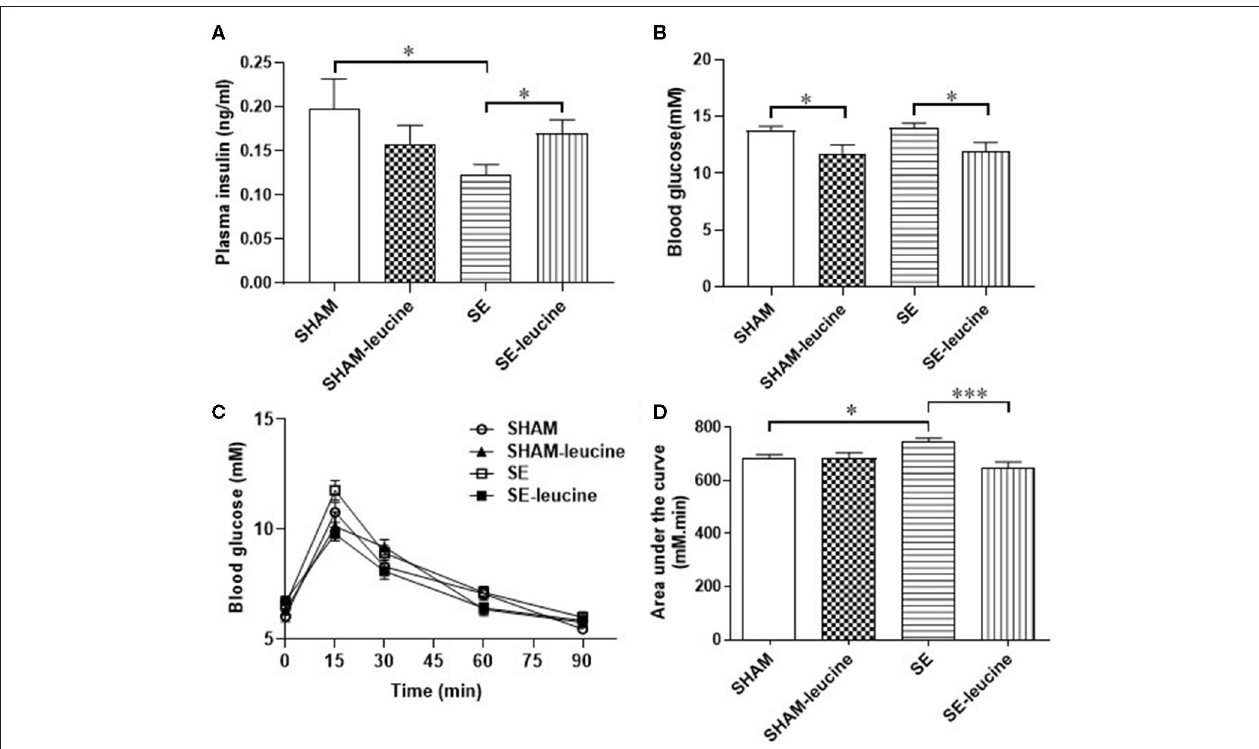
FIGURE 1 | Blood glucose metabolic profile in female offspring. Plasma insulin (A) and blood glucose (B) level in female offspring at 13 weeks. Blood glucose levels during Intraperitoneal glucose tolerance test (IPGTT, C ) and the area under the curve (D) at 12 weeks. Results are expressed as the mean ± SEM ( n = 8), and analyzed by two-way ANOVA, followed by post-hoc LSD tests. * P < 0.05, *** P <